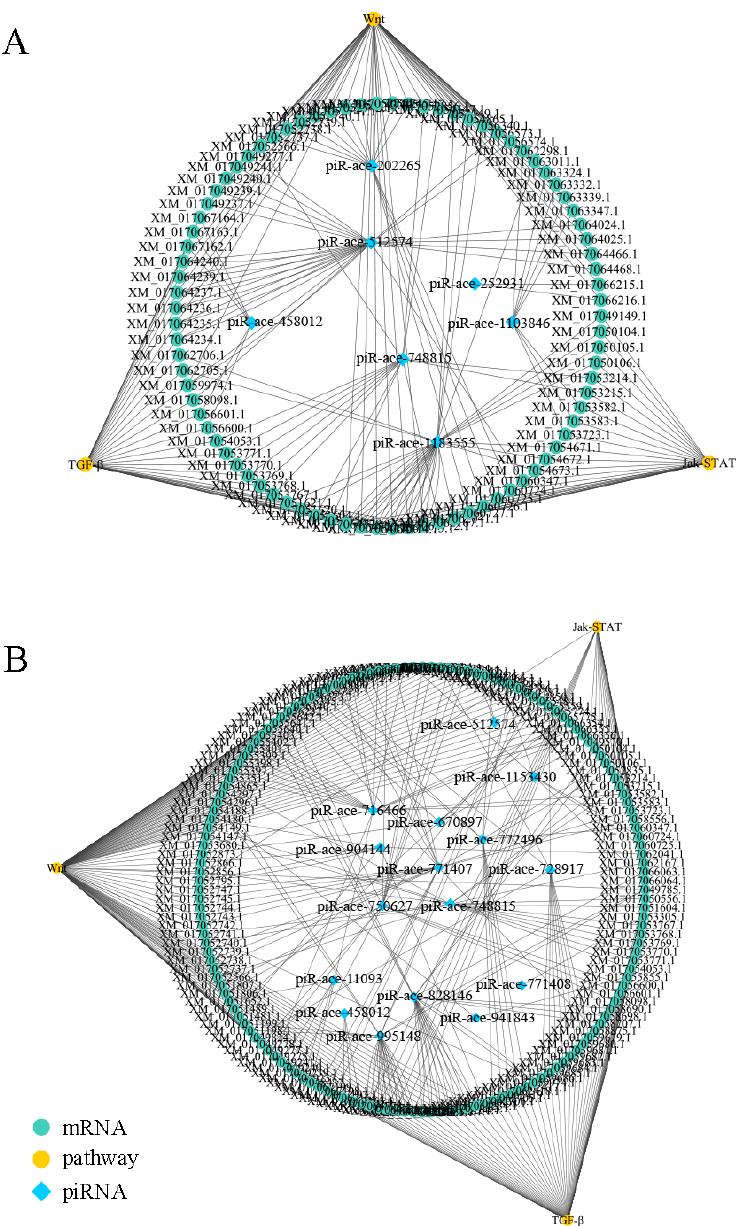
Figure 6. Regulatory network of A. c. cerana worker larvae. ( A ) Regulatory network of DEpiRNAs in Ac4 vs. Ac5. ( B ) Regulatory network of DEpiRNAs in Ac5 vs. Ac6.